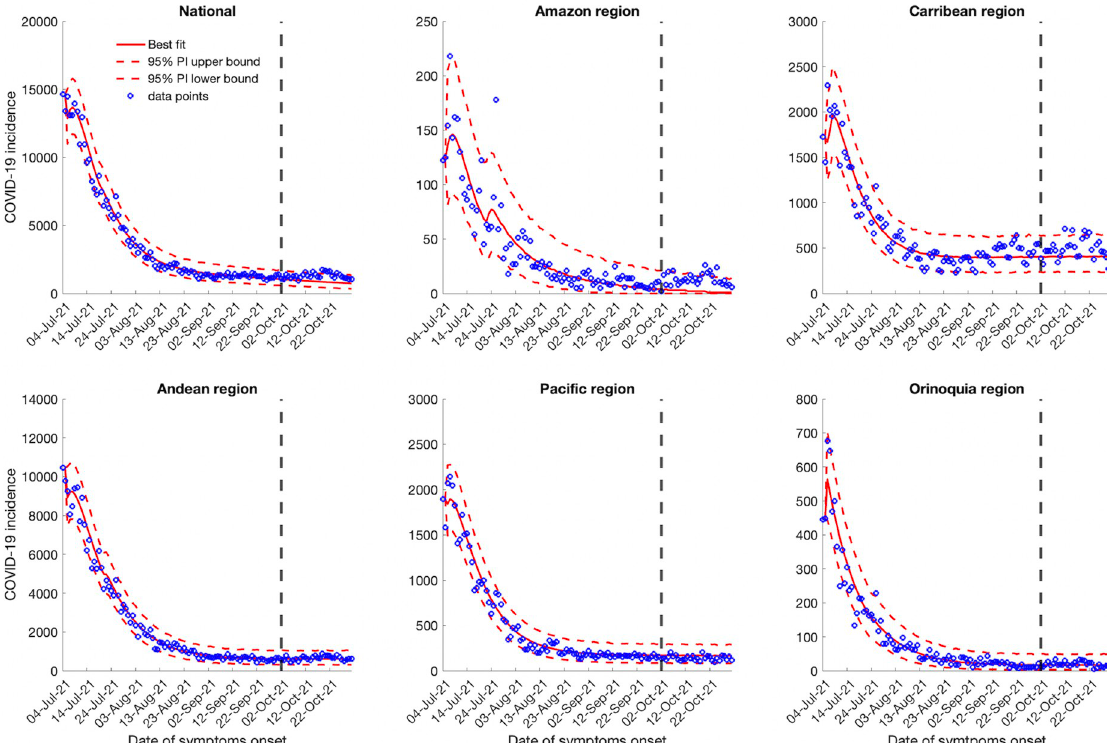
Fig 5. 30-days ahead forecast of the national and regional COVID-19 epidemic curves in Colombia by calibrating the sub-epidemic wave model from July 4, 2021 to October 1, 2021. The blue circles correspond to the data points; the solid red line indicates the best model fit, and the red dashed lines represent the 95% prediction interval. The vertical black dashed line represents the time of the start of the forecast